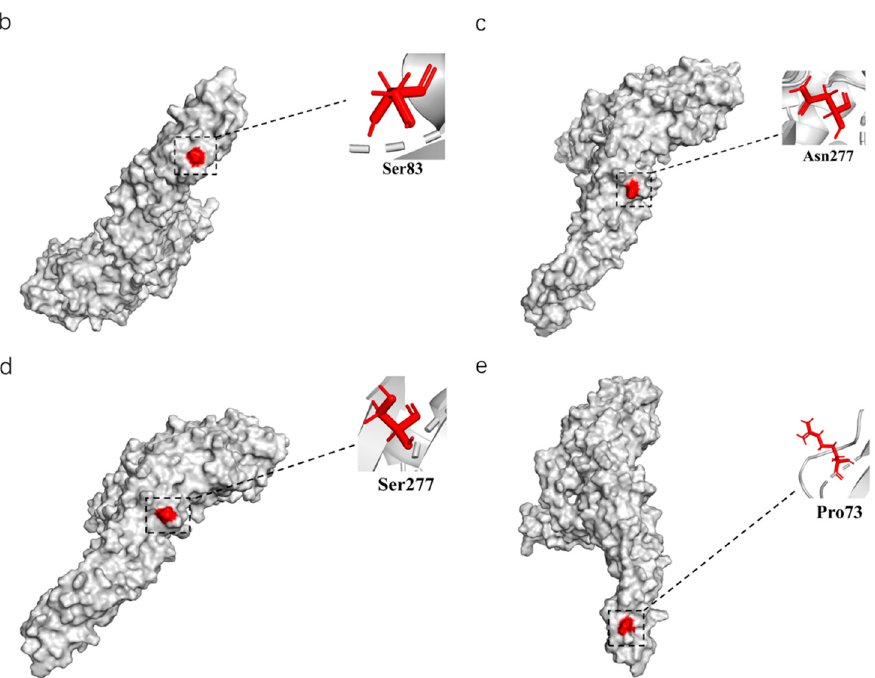
Figure 4. The phylogenetic analysis of the E amino acid sequence and a schematic diagram of the structure simulation of the E protein of different clusters of TMUV using AlphaFold2. ( a ) The ML tree of the E protein of TMUV and the characteristic amino acid sites are also marked with different colors. ( b ) Cluster 1 characteristic amino acid sites. ( c ) Subcluster 2.1 characteristic amino acid sites. ( d ) Subcluster 2.2 characteristic amino acid sites. ( e ) Cluster 3 characteristic amino acid sites.